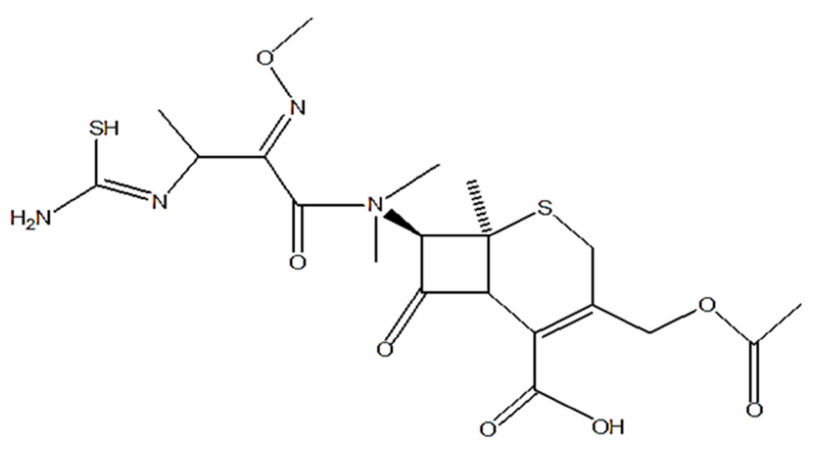
Figure 1. Chemical structure of